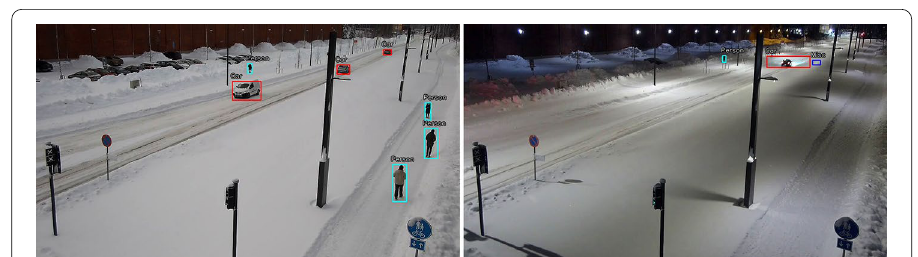
Fig. 5 Samples of detections made with MoDeCla in winter